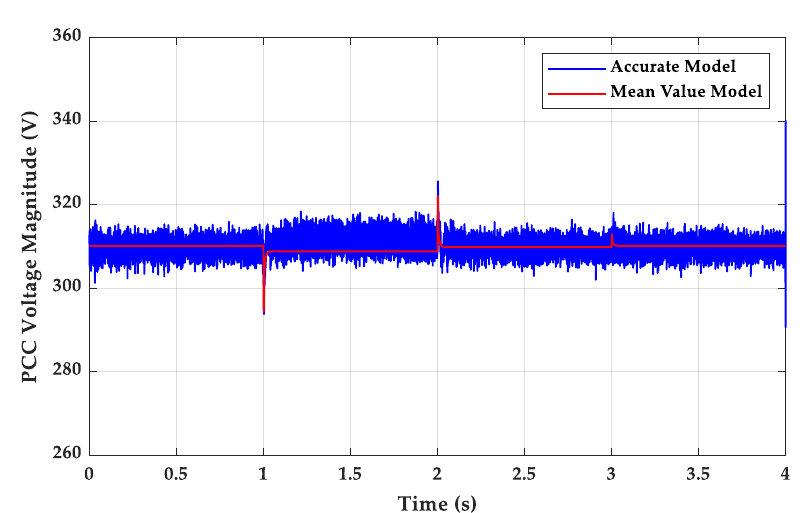
Figure 6. The dc-side voltage response.